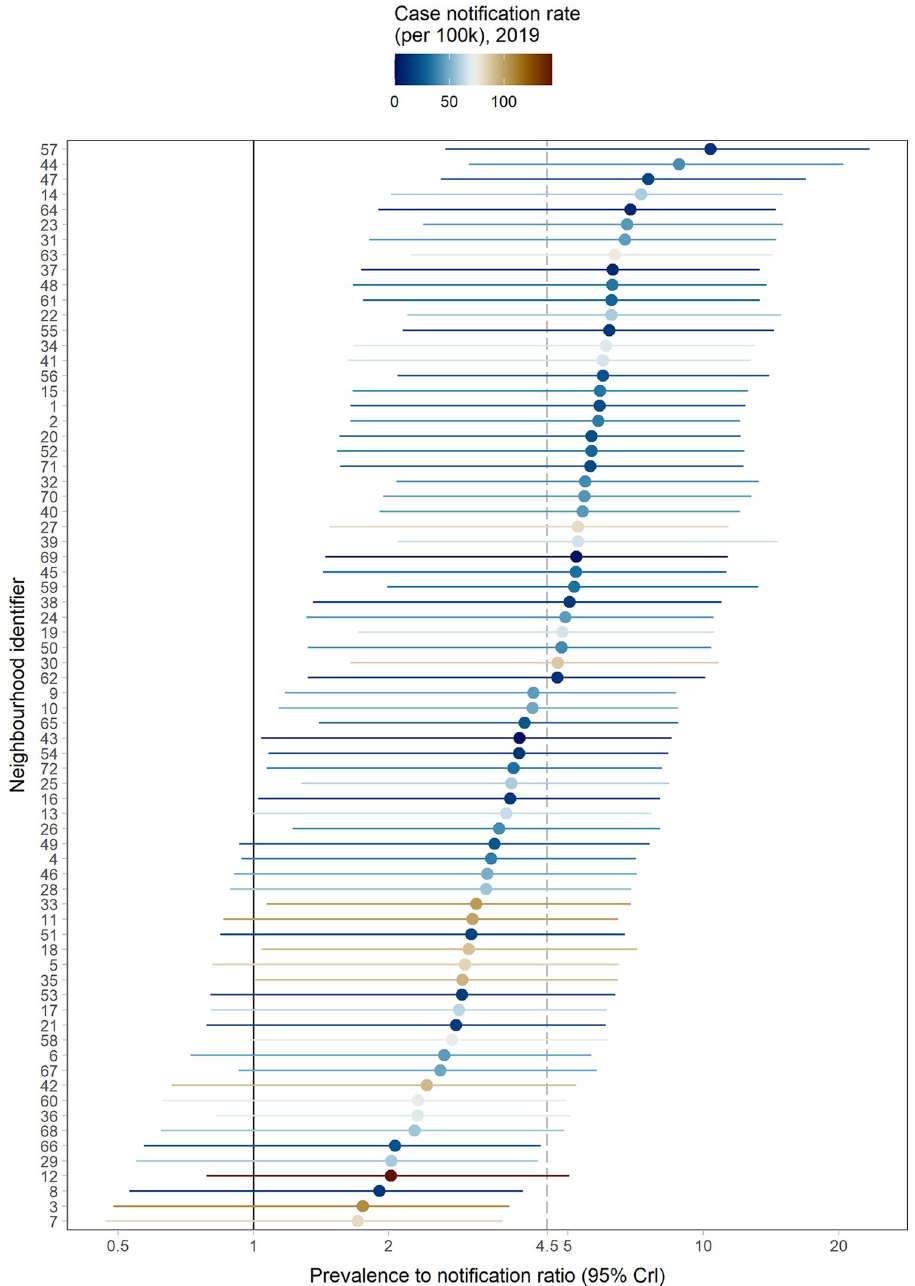
Fig 3. Neighbourhood level TB prevalence to notification ratios (with 95% Crls) using final models. The neighbourhoods were ordered according to prevalence to notification ratio size. The dashed line is the mean prevalence to notification ratio. Crl Credible